Question: Describe this figure in one sentence.
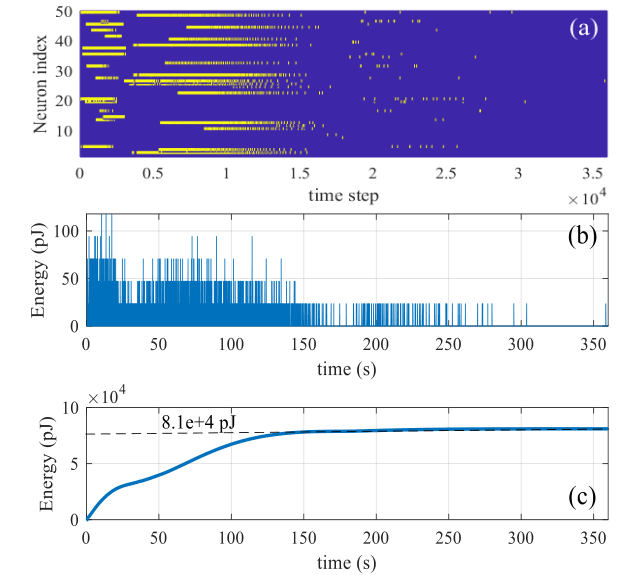
Answer: (a) shows the spiking pattern of the SNN for the  given task, demonstrating efficient task execution with  minimal spike usage. The spiking pattern indicates three  distinct spiking regimes corresponding to changes in control  input behaviors: a shift in input direction around 𝑡= 40s and  input convergence to near zero at 𝑡= 200s. The SNN emitted  3434 spikes across 50 LIF neurons, just 0.19% of the potential  1,800,000 spikes, showcasing a biologically plausible spiking  distribution in the network. Figure 10(b) shows the temporal  variation of the consumed energy per time step for spike  emission. It reveals that most of the energy is consumed before  𝑡= 150s where the elements of the input vector are  significantly greater than zero and after 𝑡= 150s, where the  input vector elements are almost near to zero the consumed  energy is considerably reduced, and this is vividly apparent in  the obtained spiking pattern.